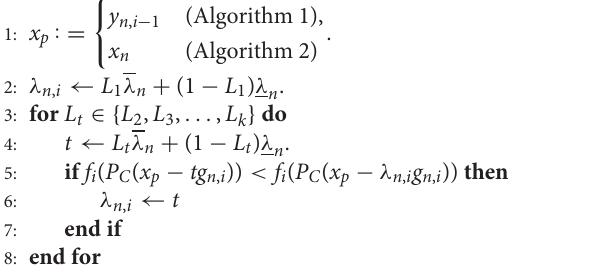
Algorithm 3: Discrete argmin line search algorithm